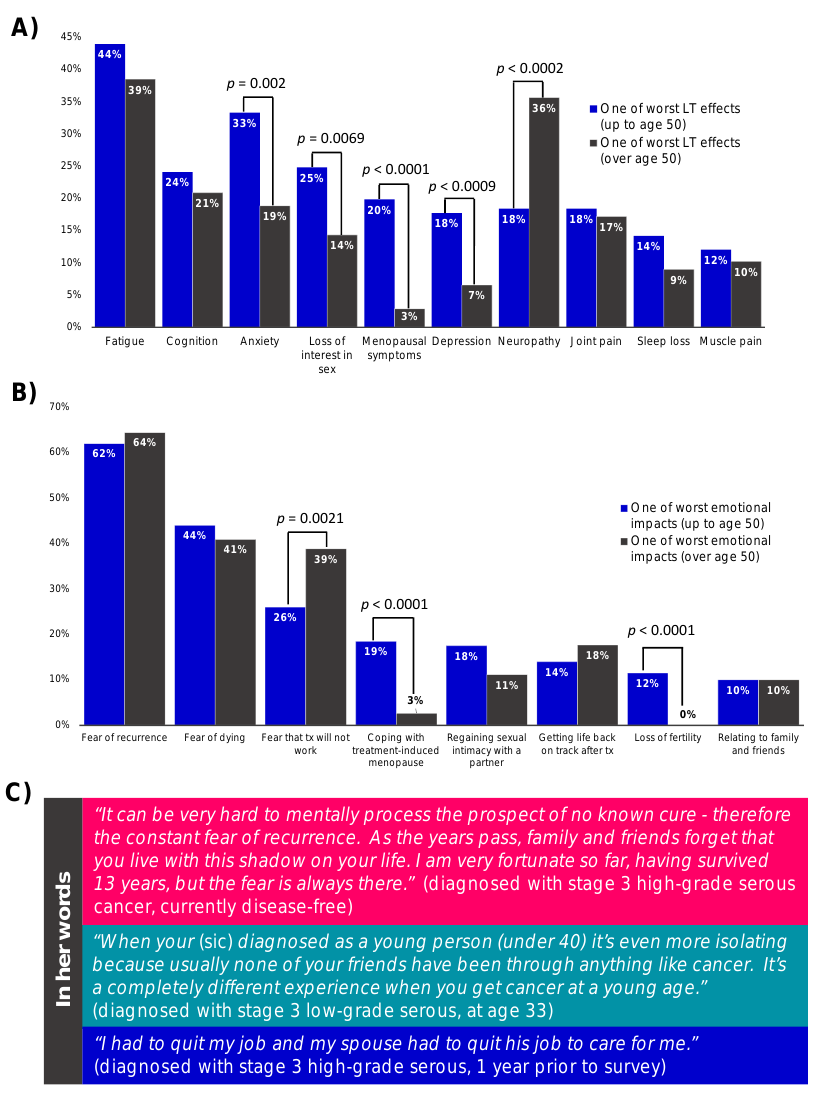
Figure 5. Summarizing the impact of ovarian cancer. The proportion of respondents considering a specific long-term effect of treatment ( A ) or emotional impact of ovarian cancer ( B ) one of the three worst they experienced is shown. Statistically significant differences between those diagnosed at